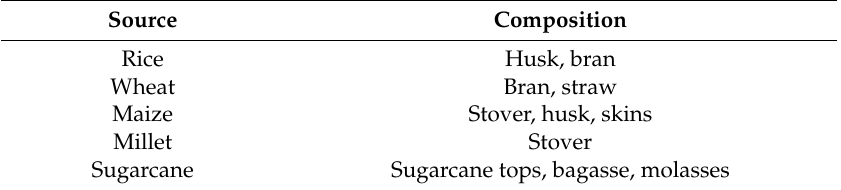
Table 2. Crop residues produced by major crops